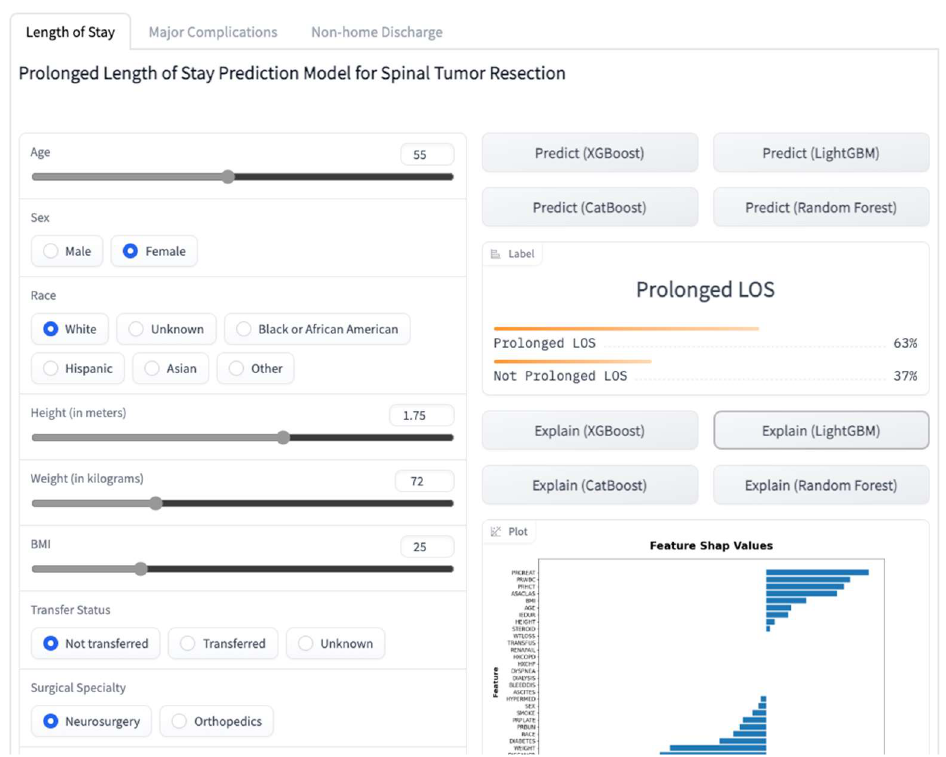
Figure 1. A screenshot of the online web